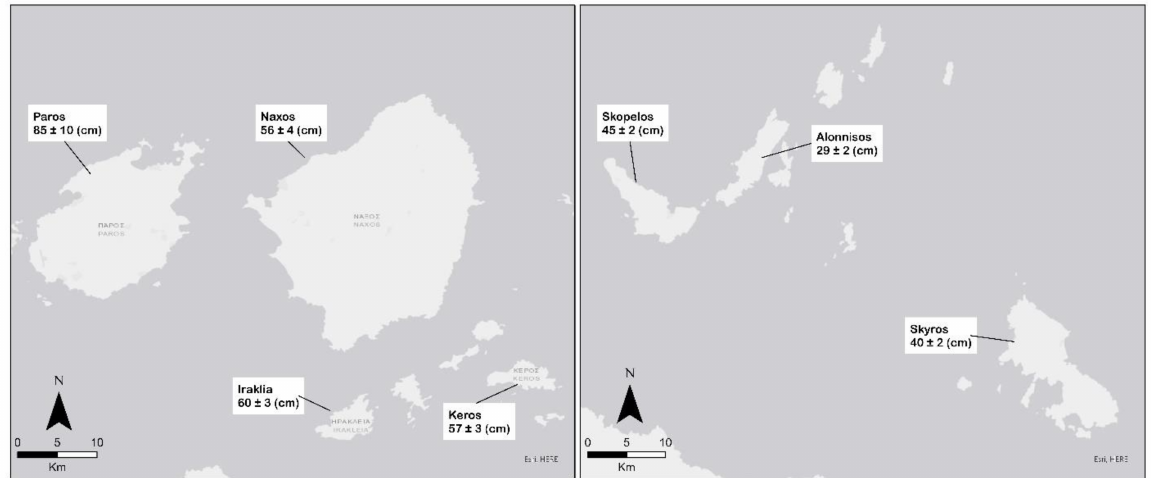
Figure 5. Average coseismic subsidence (cm) based on submerged tidal notches at the islands of Naxos, Keros, Iraklia, Paros, Skopelos, Alonnisos and